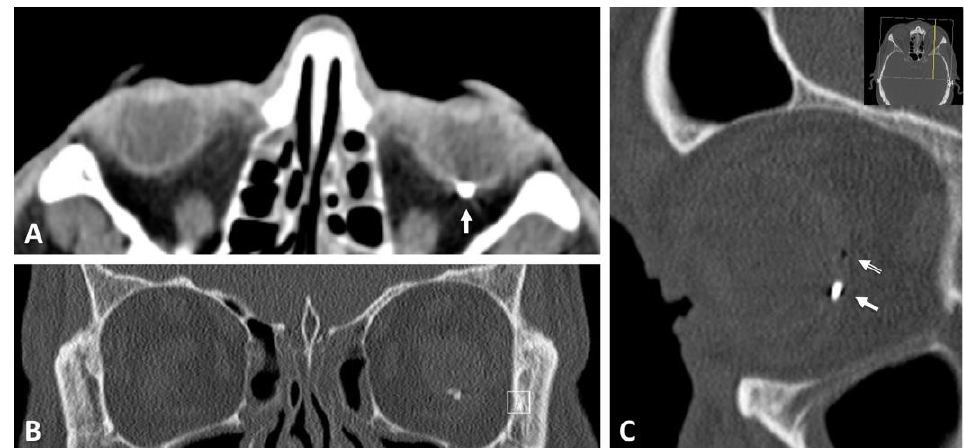
Figure 5. Computed tomographic images from the same patient mentioned in Figure 4. Frontal ( A ), axial ( B ) and sagittal ( C ) images, location of the metallic foreign body at the posterior pole (white arrow).